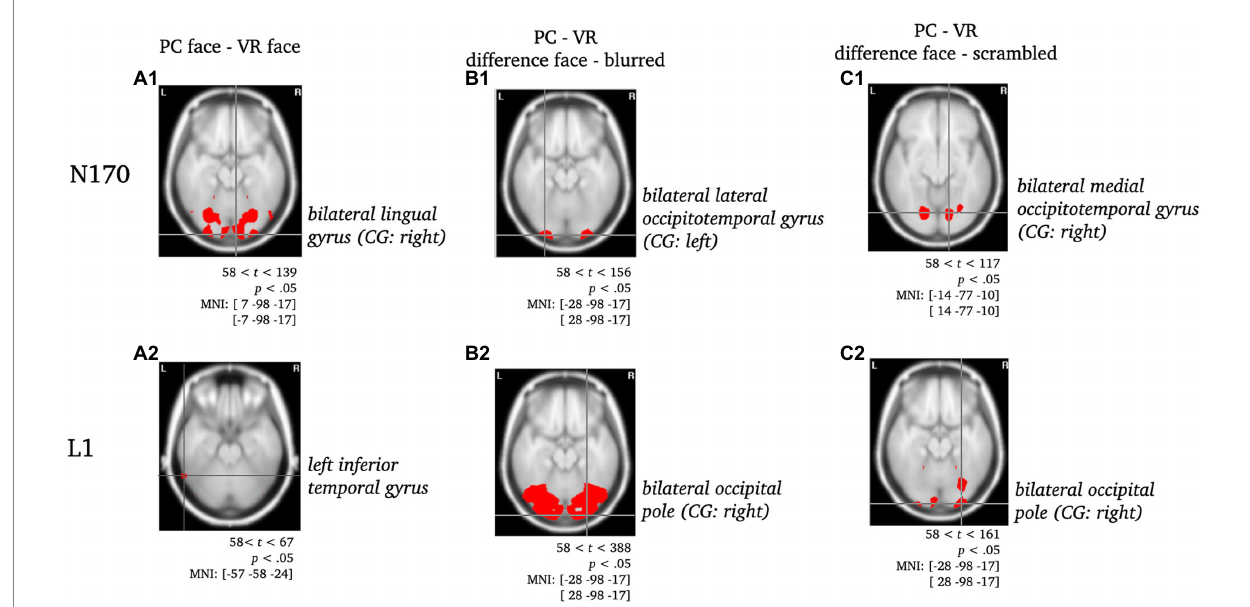
FIGURE 5 Statistically significant sources for the difference between PC-faces and VR-faces during N170 and L1. Statistically significant differences in activity are marked red, with p < 0.05, t crit = 58. Per panel, the center of gravity (CG) is labeled and the respective MNI coordinates are given. Per component, the raw comparison of PC faces and VR faces is depicted [panels A ]. Moreover, this comparison was controlled for blurred faces [panels B ; PC (face - blurred) minus VR (face - blurred)] and scrambled faces [panels C , PC (face - scrambled) minus VR (face - scrambled); cf. ERPs in electrode